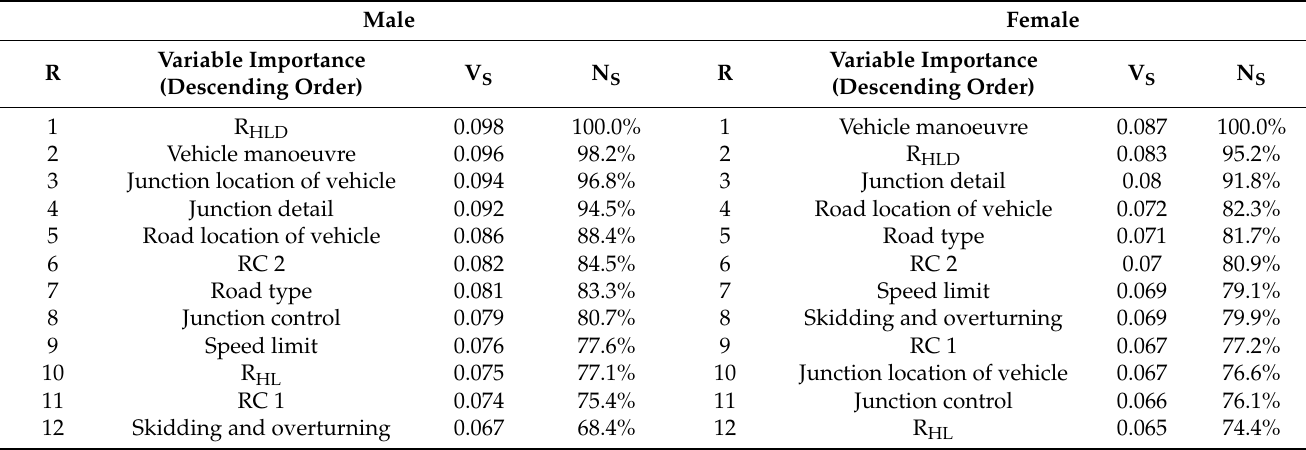
Table 5. The critical variable significance model for the input